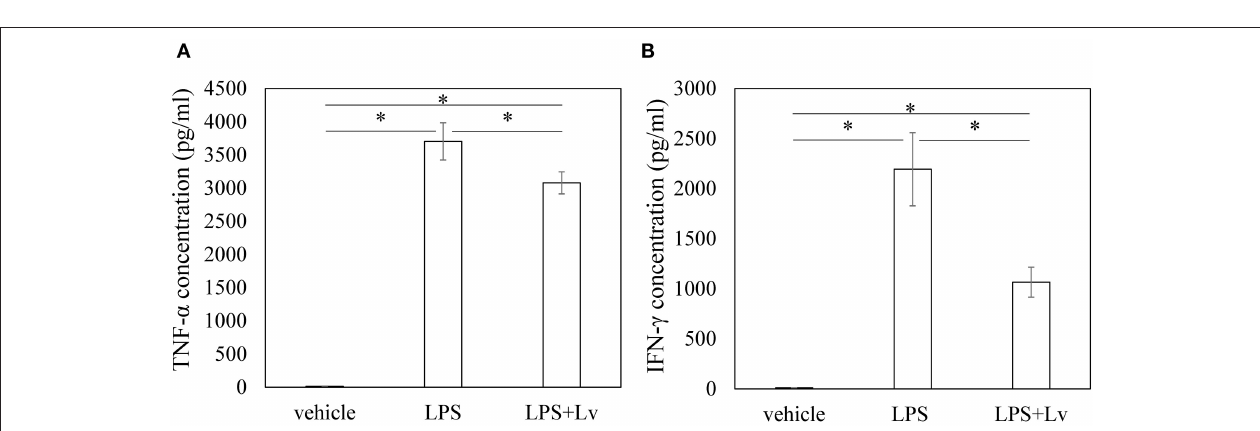
FIGURE 1 | Effect of peptide Lv on LPS-mediated inflammatory cytokine production. (A) Tnfa , (B) Il1b , (C) Il6 , and (D) Ifng expression levels in vehicle-, LPS-, and LPS + peptide Lv (LPS + Lv)-treated BMM at 6 and 24h. Relative expression was determined based on the expression in vehicle-treated BMM at 6h. (B) TNF- α protein levels in the culture supernatant of vehicle-, LPS-, and LPS + peptide Lv (LPS + Lv)-treated BMM. Values are mean ± SE ( n = 8). * p < 0.05.